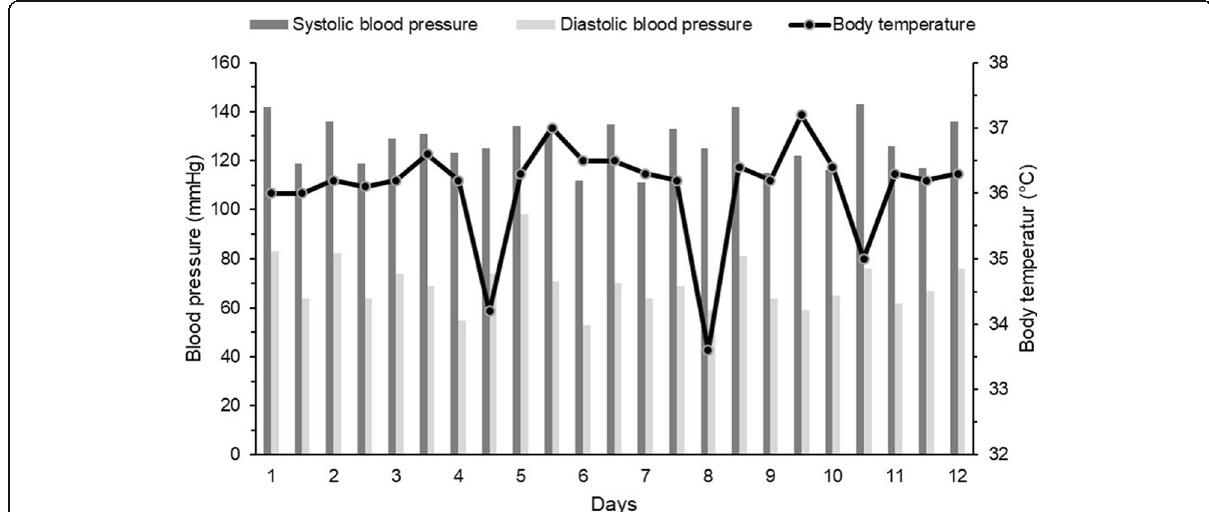
Fig. 2 Evolution of blood pressure and body temperature over twelve days with measurement every twelve hours at 6:00 AM and 6:00